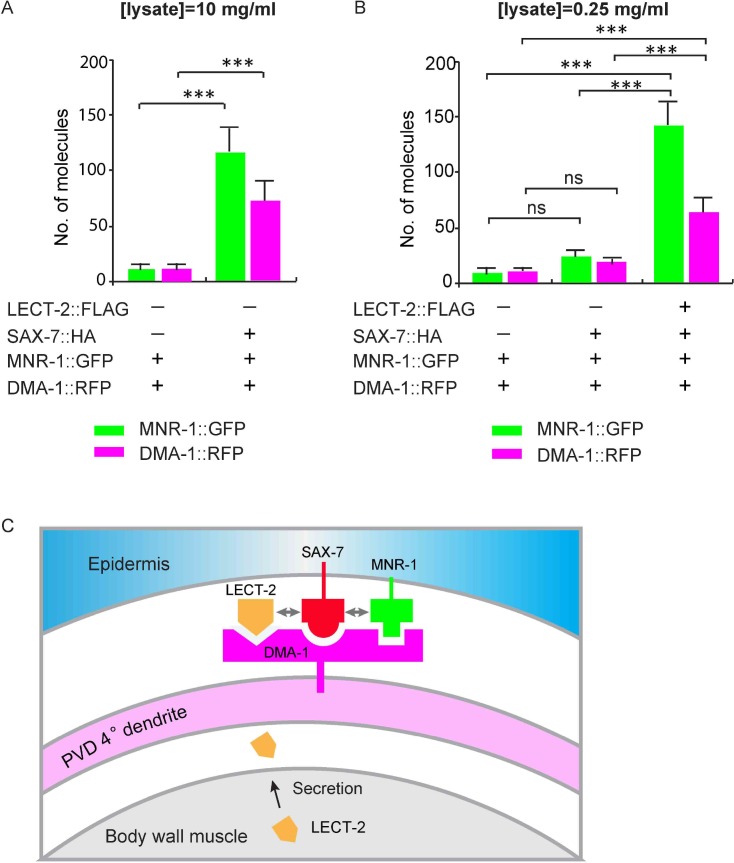
LECT-2 enhances the binding among SAX-7, MNR-1 and DMA-1 in vitro.(A–B) Drosophila S2 cells expressing DMA-1::RFP and MNR-1::GFP, with or without co-expression of SAX-7::HA and LECT-2::FLAG, were used to detect protein interactions by SiMPull. Lysates were applied to a chamber coated with anti-HA antibody. Different lysate concentrations (10 and 0.25 mg/ml for A and B, respectively) were used in order to achieve an optimum density of fluorescent proteins. Specific pull-down of DMA-1 and MNR-1 were observed from lysate co-expressing SAX-7 HA, but not lysates without SAX-7::HA. The addition of LECT-2::FLAG required 40-folds less concentration of input than the sample without LECT-2 co-expression, to achieve similar MNR-1 and DMA-1 pull-down outputs. 10 and 13 different regions of the imaging surface were imaged and quantified for the two groups shown in (A). 5, 5 and 12 different regions of the imaging surface were imaged and quantified for the three groups shown in (B). One way ANOVA with the Tukey correction was used for statistical analysis. ***p<0.0001. ns: not significant. Data are represented as mean ± SEM. (C) A cartoon showing that LECT-2 is secreted from body wall muscles and captured by SAX-7 on the epidermis. SAX-7 also directly binds to MNR-1. LECT-2, SAX-7 and MNR-1 form a combinational dendritic guidance cue to bind and activate dendritic receptor DMA-1 to regulate targeting and morphogenesis of PVD dendrites.